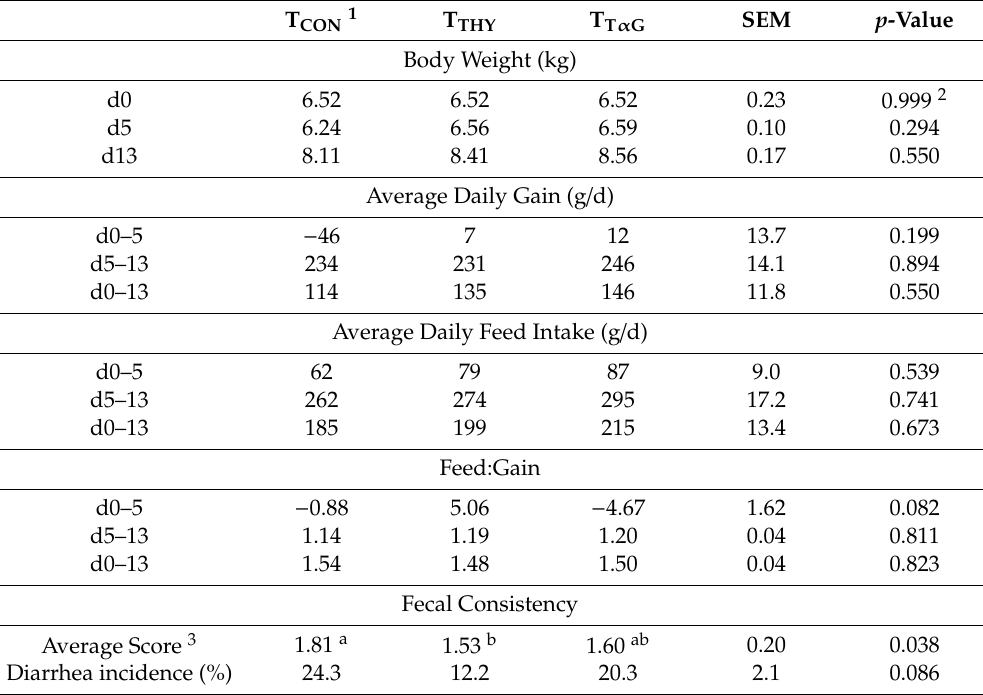
Table 2. The effect of dietary treatment on the animal performance of piglets from d0 to d13 post ‐ weaning. Table2. Thee ff ectofdietarytreatmentontheanimalperformanceofpigletsfromd0tod13post-weaning.